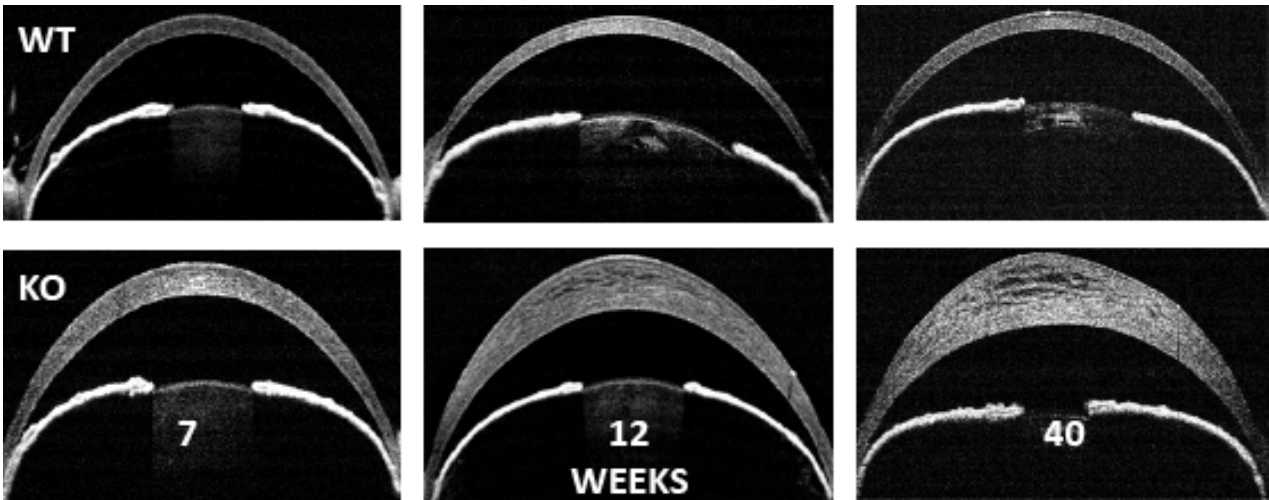
Figure 1. Corneal thickness of SLC4A11 wild-type vs. knock-out. Optical coherence tomography images of wild-type and SLC4A11 KO mice [35] at 7, 12, and 40 weeks, showing progressive corneal edema in KO.